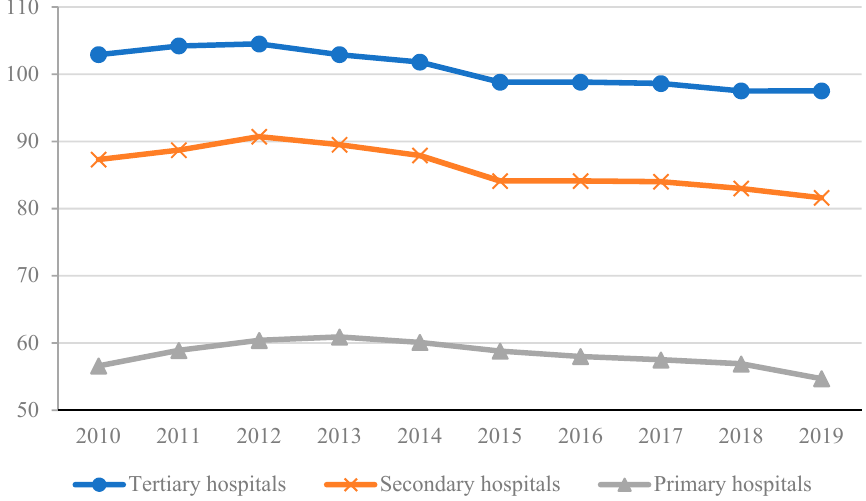
Figure 3. Average annual bed utilization rate of hospitals at all levels, township health centers and community health service centers. Data: National Health Commission of the PRC.